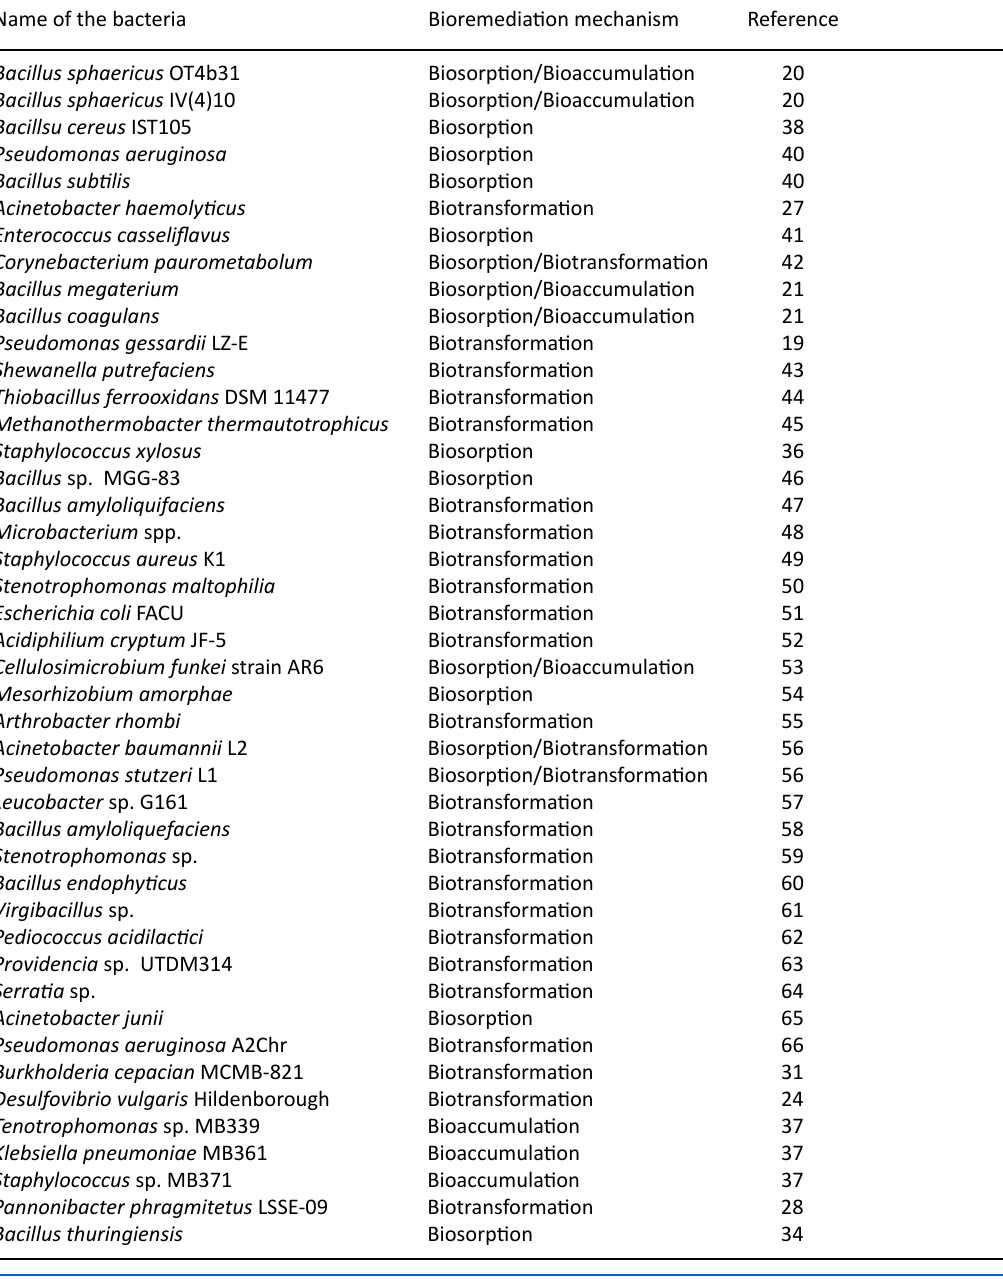
table 1. List of bacteria and their mechanisms for Cr(VI) detoxification Name of the